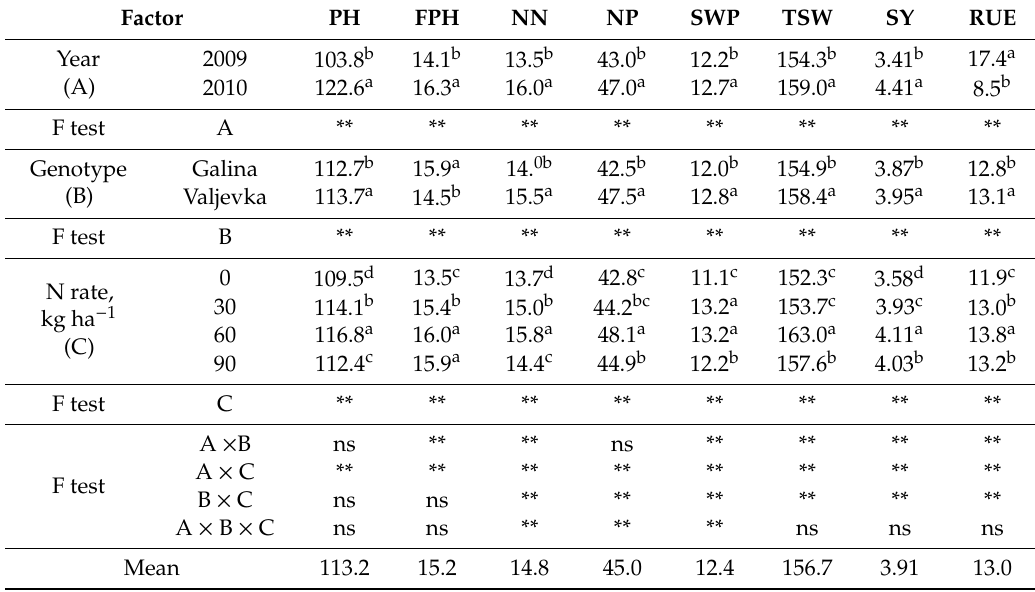
Table 1. Year, genotype and N rate e ff ects on morphological and productive parameters and